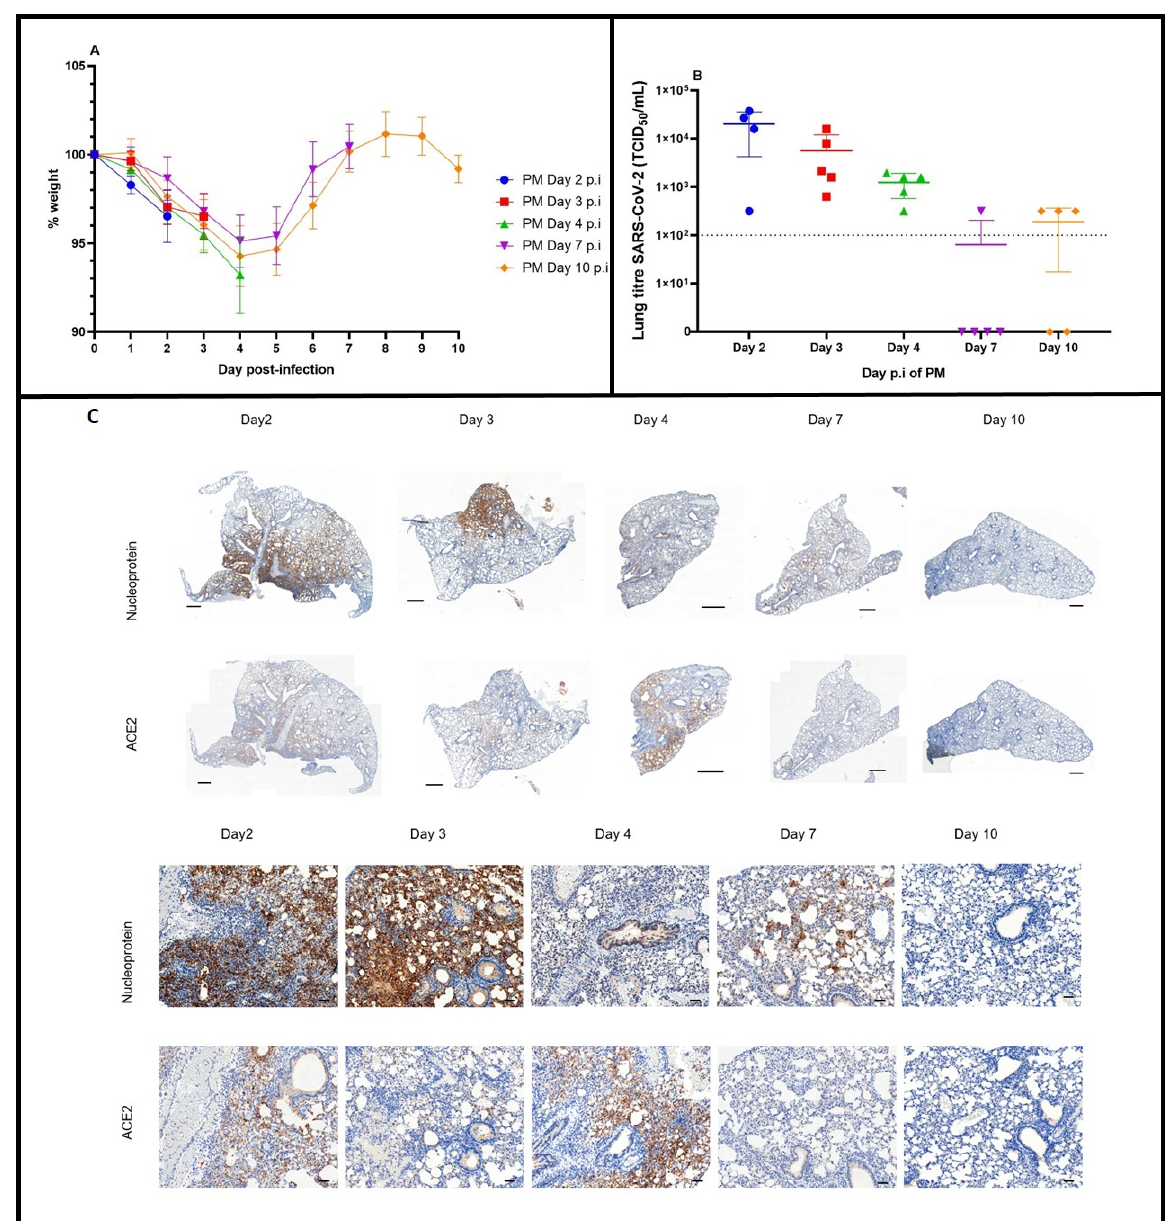
Figure 3. SARS-CoV-2 Vic1 infection in mice over time. Groups of five mice were transduced with Ad5-CMV-hACE2 and five days later infected with 1.6 × 10 5 TCID 50 /50 µL of SARS-CoV-2 Vic1 by the i.n. route. At day 2 p.i. (blue symbols and lines), day 3 (red symbols and lines) day 4 (green symbols and lines), day 7 (purple symbols and lines) or day 10 (orange symbols and lines), a group of mice were humanely killed. (A) Mean group weight (+/ − SEM as error bars) post-infection as a percentage, where day 0 weight is 100%. (B) Titre of viable SARS-CoV-2 in lungs at different time-points p.i. Individual values for each mouse shown with a line at the mean. Limit of detection = 100 TCID 50 (dotted line). (C) IHC staining for SARS-CoV-2 nucleoprotein or ACE2 protein in mouse lung at 2, 3, 4, 7 and 10 days p.i. with 10 5 TCID 50 Vic1. Nucleoprotein staining was detected on days 2 and 3 p.i. and reduced on days 4, 7 and 10 p.i. ACE2 was detectable in lung tissue on days 2, 3, and 4 and not on days 7 and 10. Scale bars represent 500 µm in macroimages and 100 µm in magnified images. A linear model was constructed to characterise the data for viral titres in lungs at day 4 p.i. The model indicated that the effect of the exposure dose level on viral